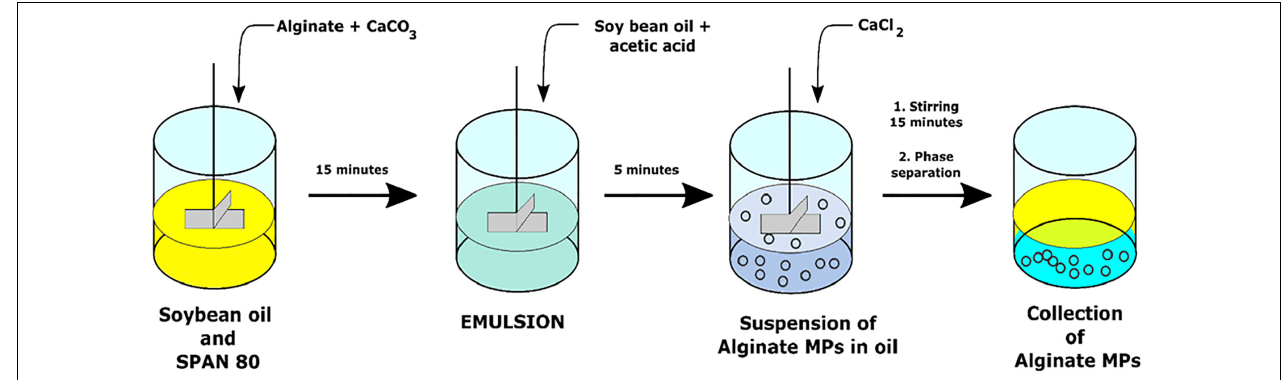
FIGURE 1 | Schematic representation of alginate MS